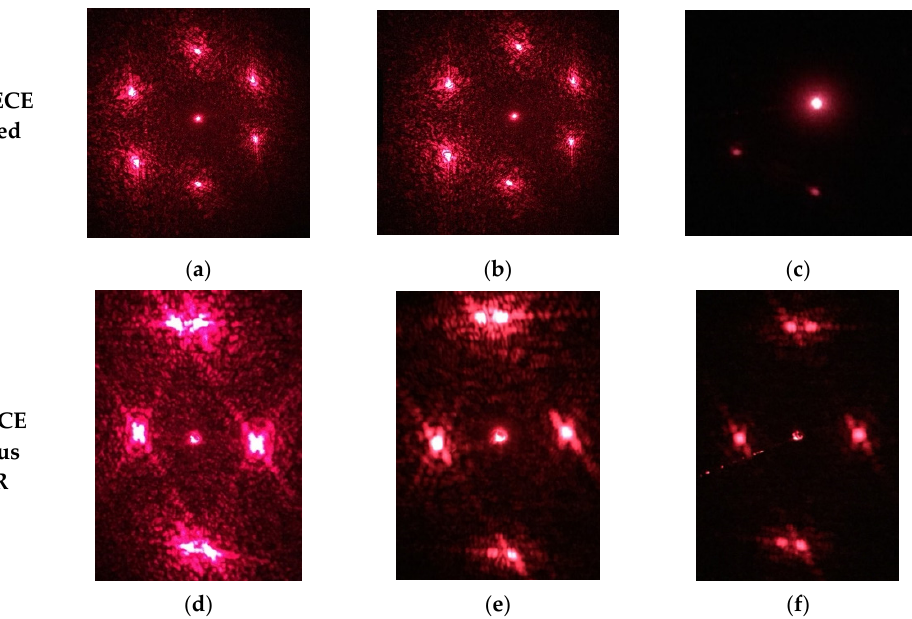
Figure 18. The intensity distributions on anterior, central, and posterior regions, which are shown in: